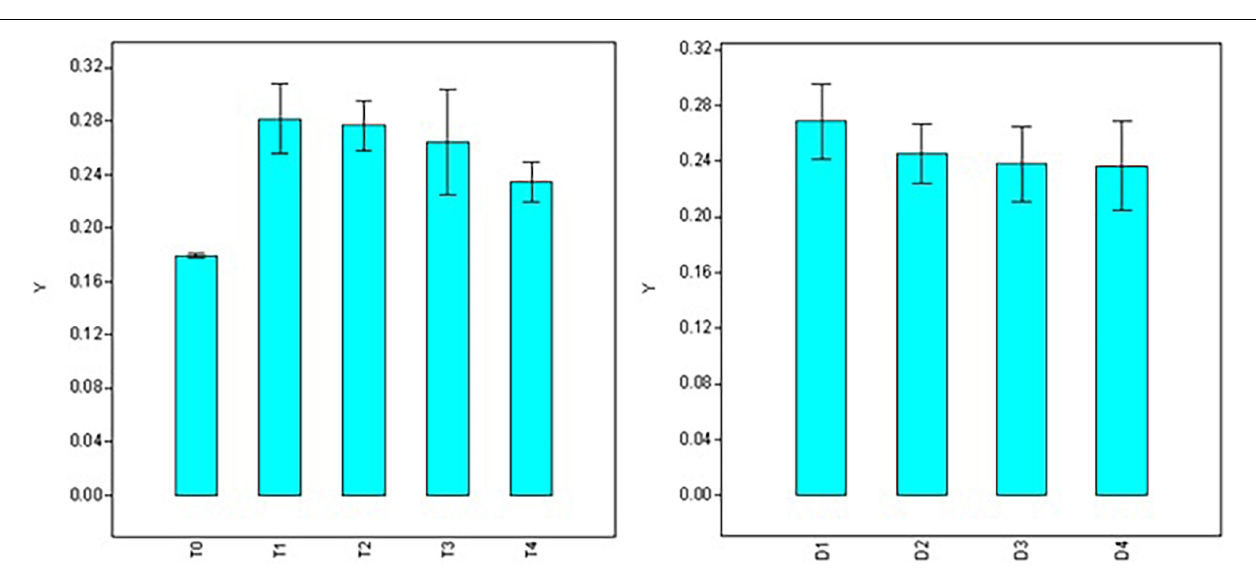
FIGURE 4 | Effect of NAA doses (left) and durations (right) on root diameter (mm) in apical shoots of Valeriana jatamansi